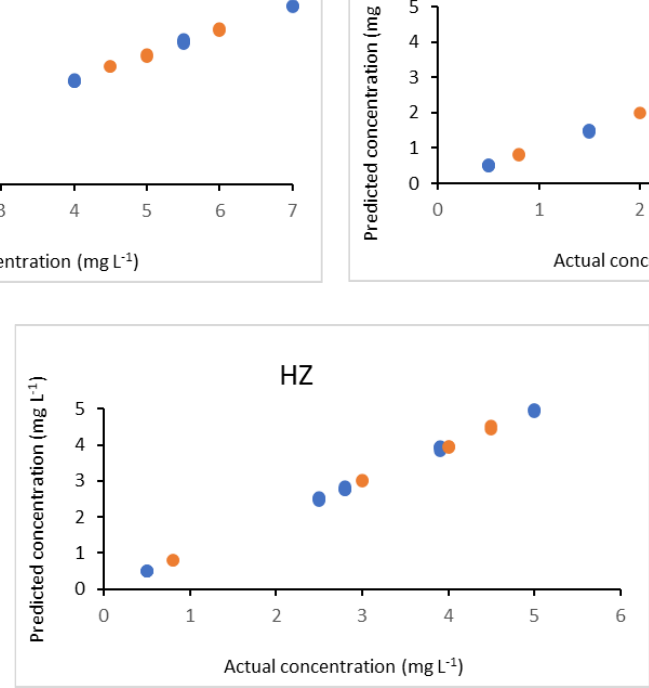
Figure 2. Plot of actual concentrations versus predicted values using MCR-ALS for calibration set ( ) and validation set ( ) of the investigated drugs. The high correlation coefficient (r 2 ) values of ≥ 0.9990 and the low relative error (RE) of ≤ 1.49% were obtained for the investigated drugs, which proved that the predictive ability of the developed MCR-ALS model is high. The performance parameters of the proposed MCR-ALS model are illustrated in Table 2. Table 2. Figures of merit of the developed MCR-ALS and PLSR models for the calibration and validation sets of the studied drugs.